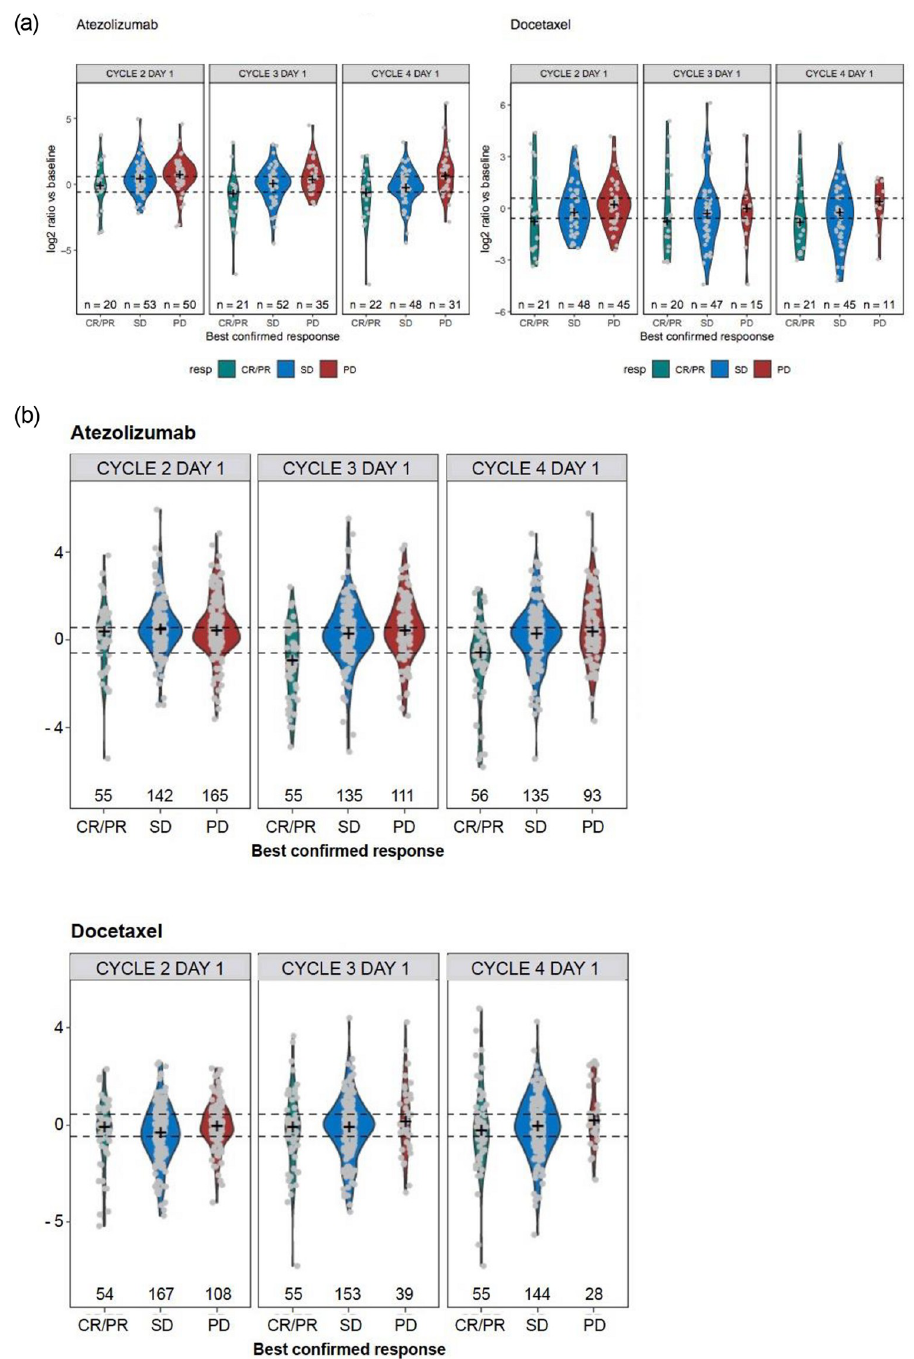
Fig 2. CRP ratios relative to pre-treatment is associated with overall response post-atezolizumab treatment but not with docetaxel treatment in the POPLAR and OAK studies. CRP log 2 ratio relative to pre-treatment or C1D1 pre-dose for each patient for each treatment arm for the first four visits with dotted lines marking an increase (1.5 fold increase) or decreased (1.5 fold decrease) relative to pre-treatment. CR, complete response; CRP, c-reactive protein; PD, disease progression; PR, partial response; RECIST v1.1, Response Evaluation Criteria in Solid Tumors version 1.1; SD, stable disease.